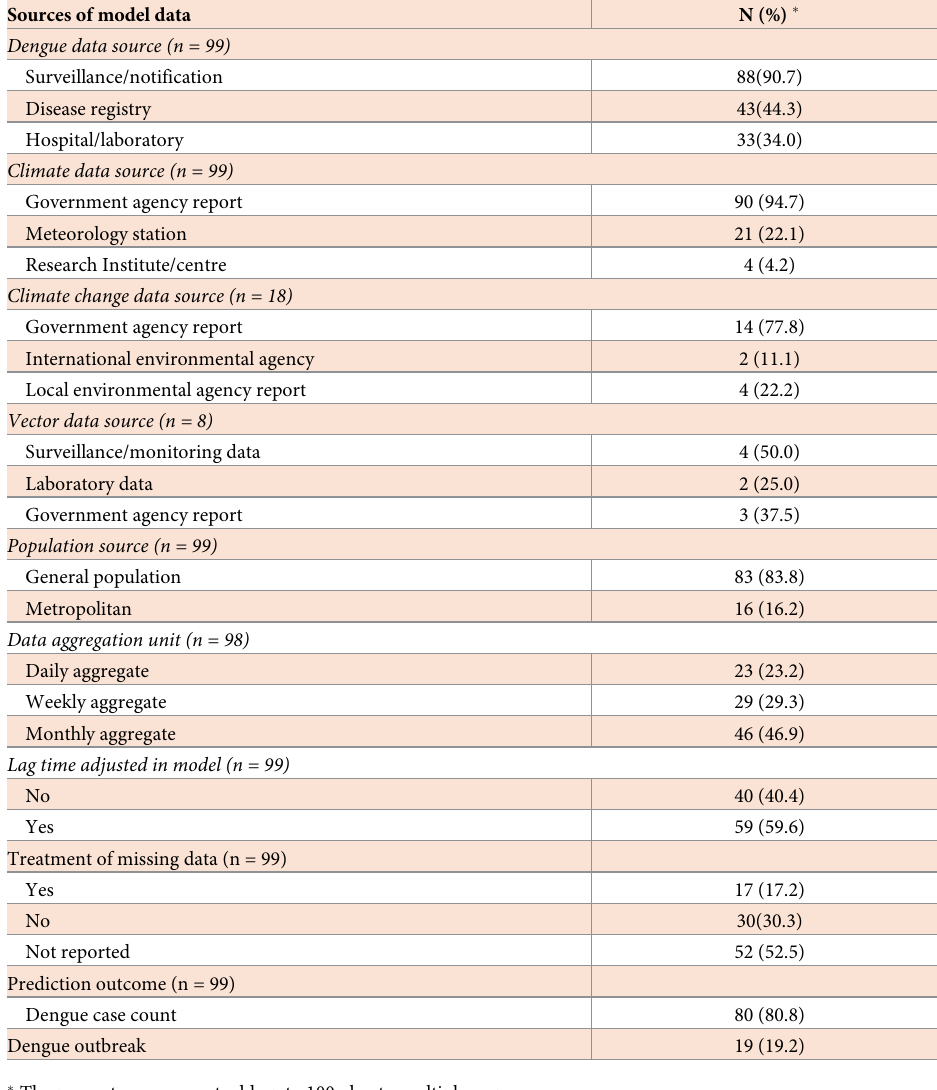
Table 2. Source of data used for